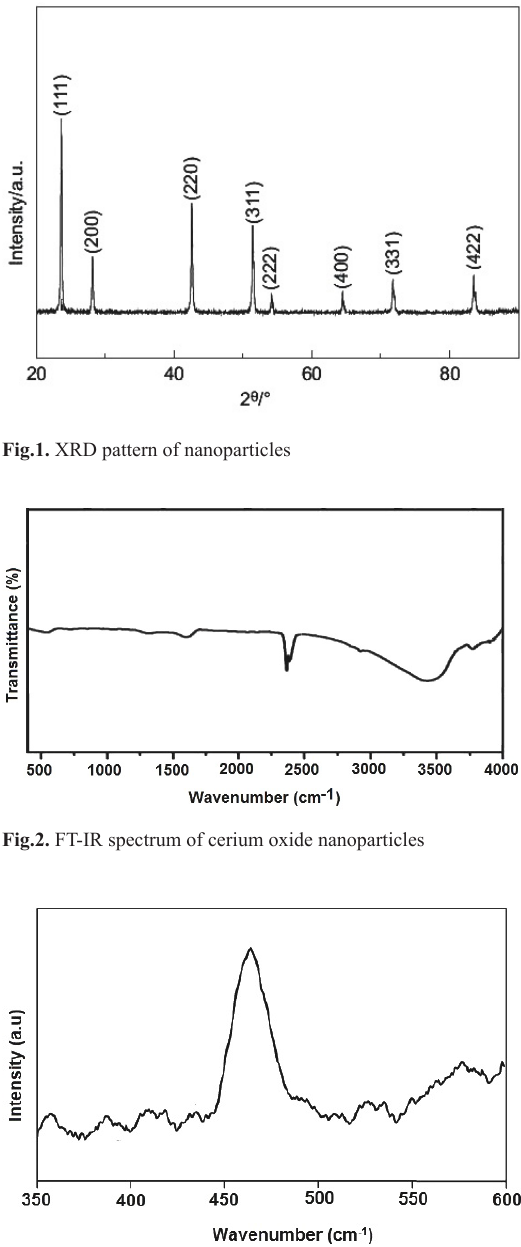
Fig.3. Raman spectrum of cerium oxide